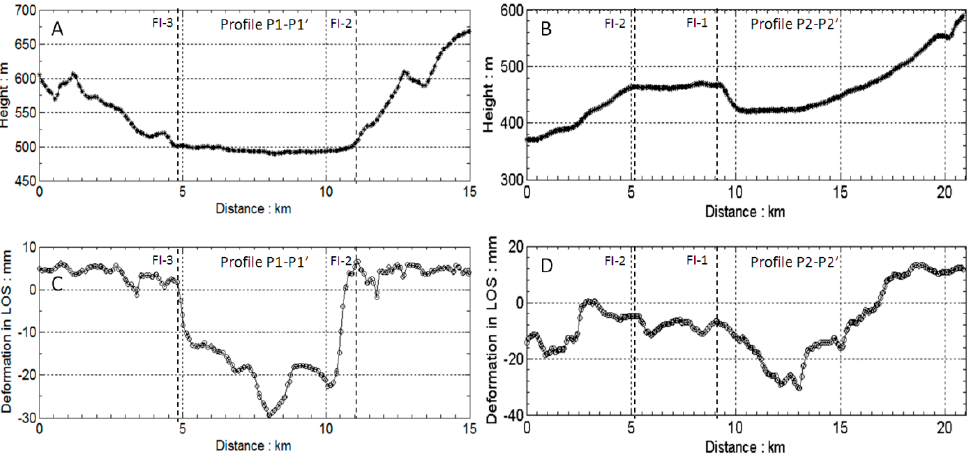
Figure 6. Profiles across the faults: ( A , B ) terrain profiles; and ( C , D ) surface deformation rate profiles. The dotted lines show the locations of faults.